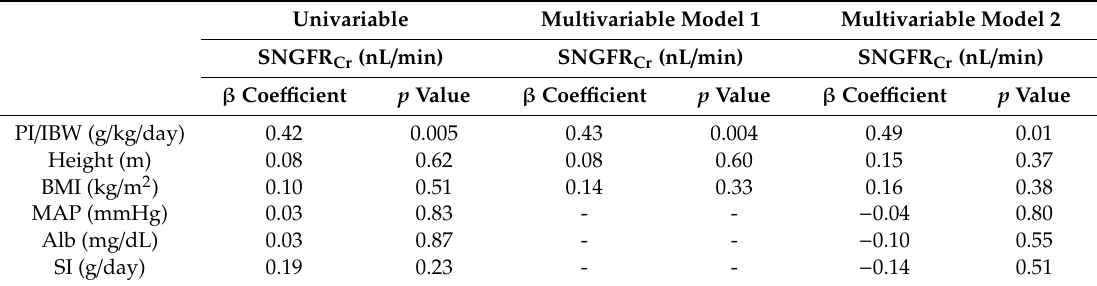
Table 4. Factors associated with single-nephron glomerular filtration rate by multiple linear regression